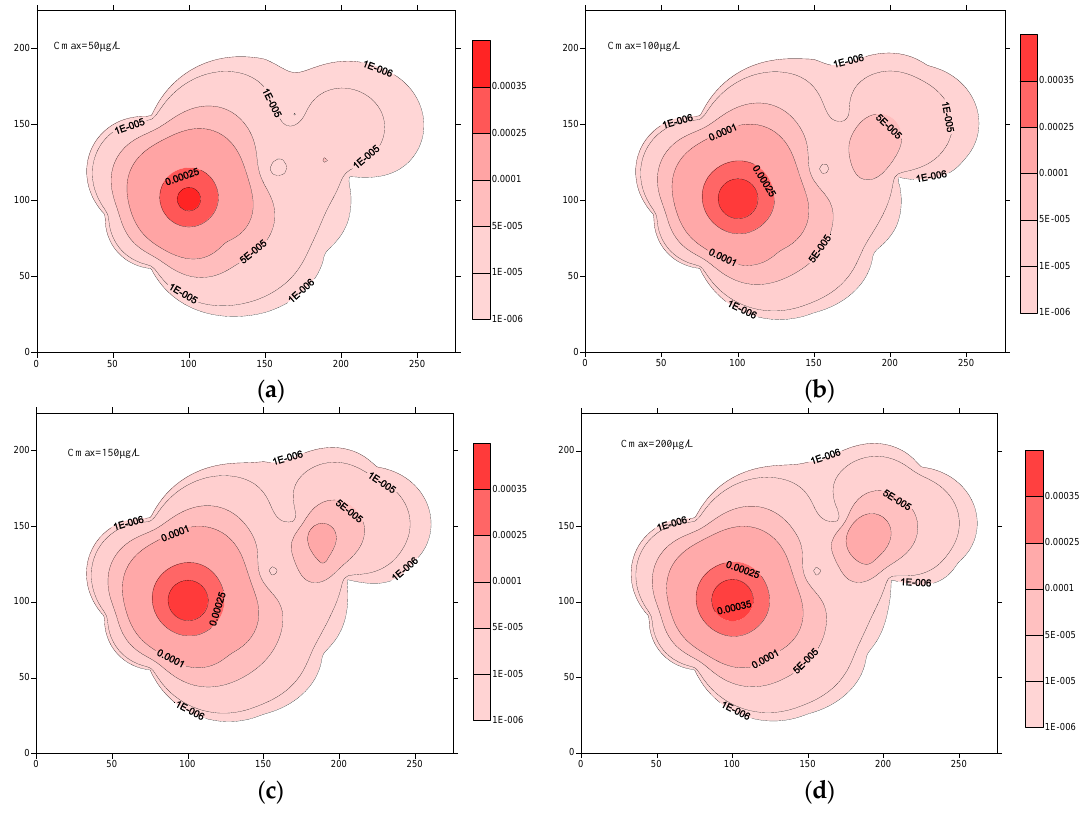
Figure 6. Predicted risk levels for four environmental standards when remediation duration is 20 years and acceptable health risk level is 0.00055, where (a), (b), (c), (d) are results under the conditions of environmental standard values being 50, 100, 150 and 200μg/L, respectively.